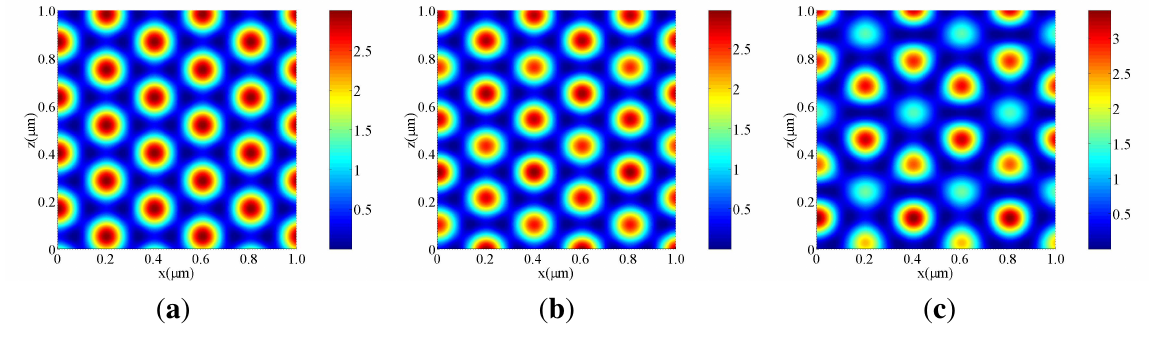
Figure 3. Calculated intensity distributions under s-polarized three-beam interference holographic exposure at a wavelength of 532 nm ( a ) in the free space and in the HPDLC film ( b ) without and ( c ) with ITO electrodes.